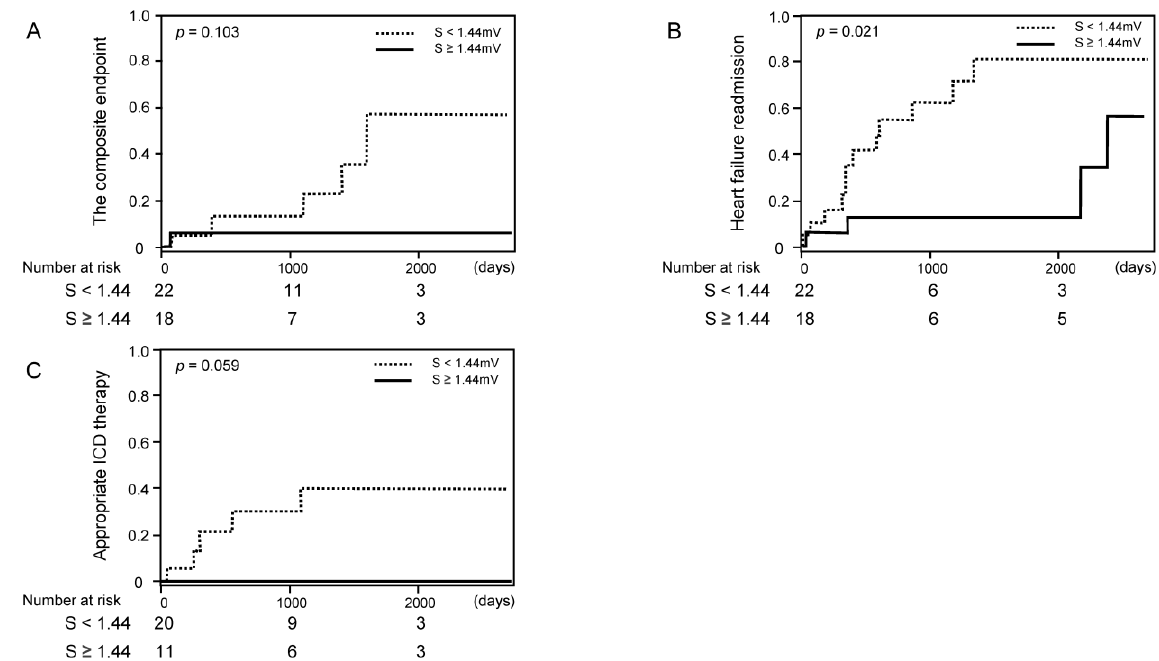
Figure 4. Cumulative incidence of clinical events stratified by the cutoff of S-wave amplitude among those without left bundle branch block (( A ) the composite endpoint of cardiovascular death, a heart transplantation, or a left ventricular assist device implantation; ( B ) heart failure readmission; ( C ) appropriate ICD therapy).